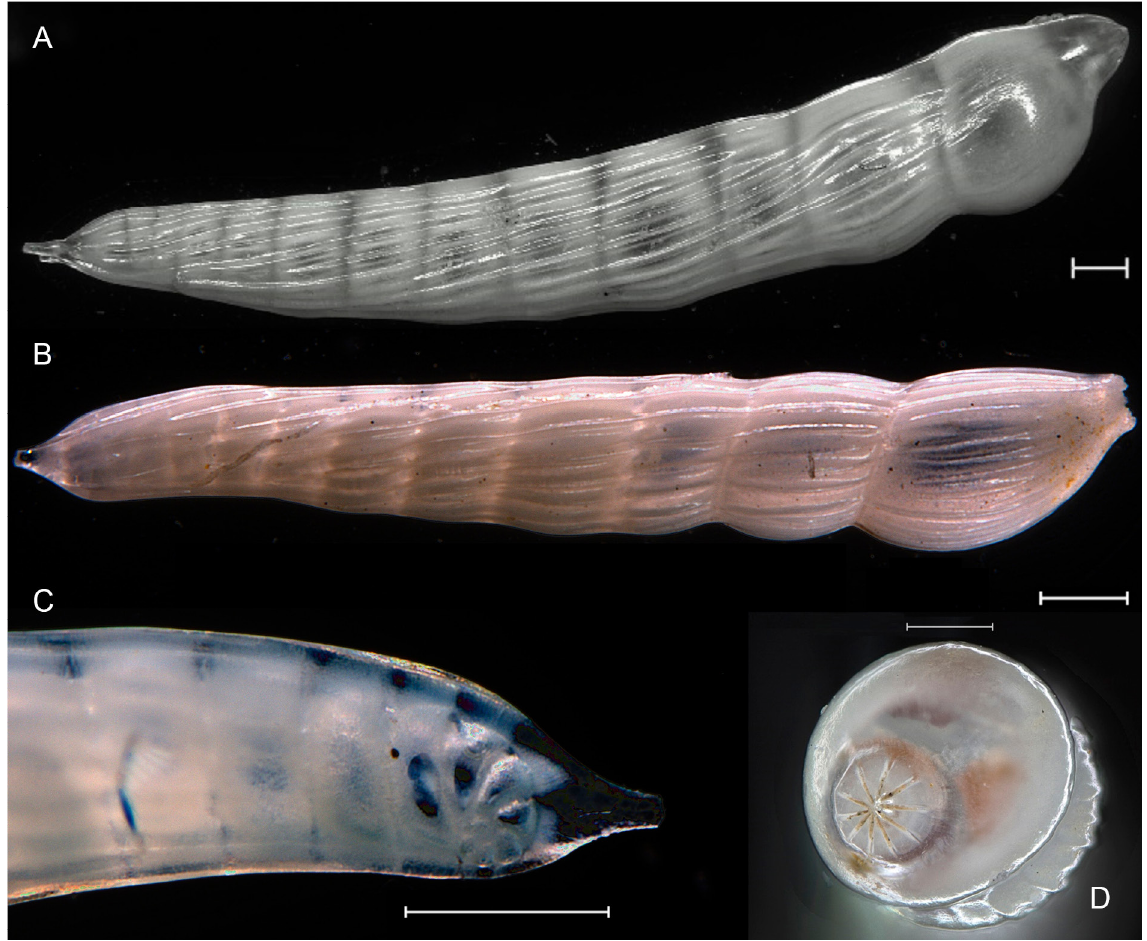
Fig. 6. Dentalina obliqua (Linnaeus, 1758). A, D . Megalosphere (BIOICE 3104, IINH 39227), side view (A) and aperture (D). B–C . Microsphere (BIOICE 2308, IINH 14759), side view (B) and details of the initial spire (C), where outer wall has been etched with acid and stained with indigo blue; diameter of proloculus < 0.02 mm. Light source combination of incident light and dark field. Scale bars = 0.25